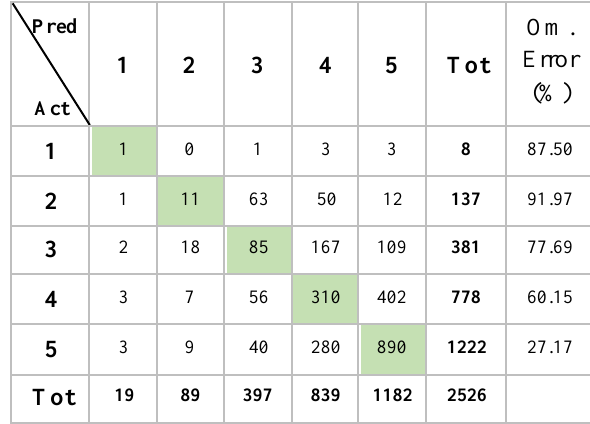
Table 1 - Confusion matrix for functional class based on density.